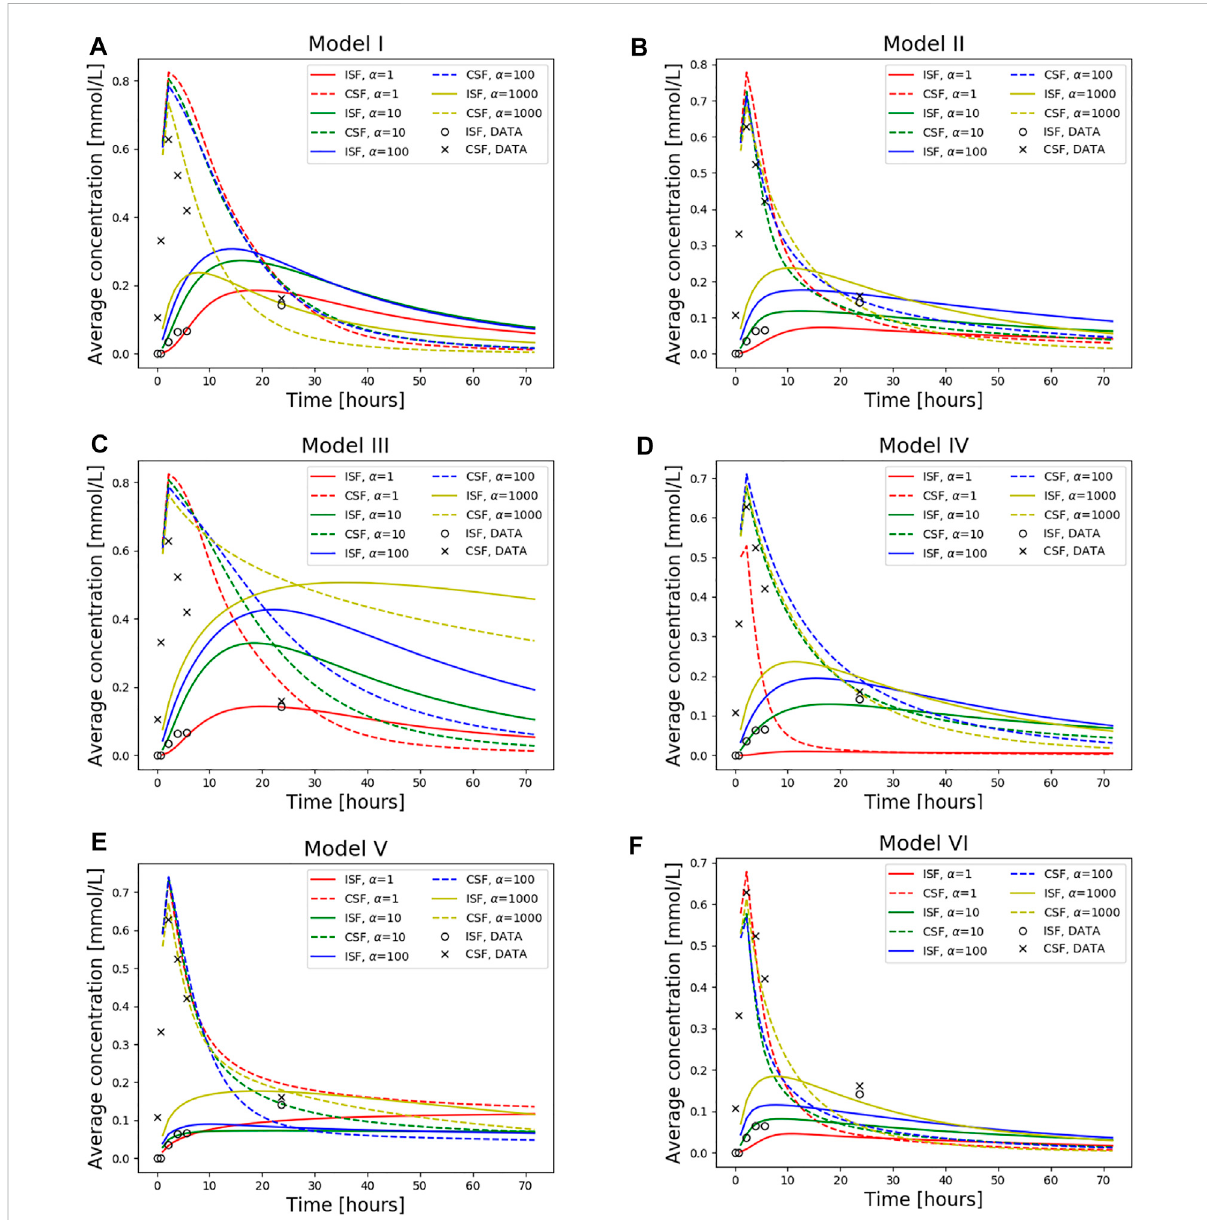
FIGURE 6 Average concentration in the parenchyma (par) and CSF over a period of 72 h. Models I-VI is used with dispersion values α = 1, 10, 100, 1,000. AlsoplottedistheconcentrationdatatakenfromT1-weightedimagesofthisspeci fi cpatientasagroundtruth.Thetracerinjection(presentfrom0to 2.24 h)isseenasasharpincreaseinCSFconcentrationatearlytimepoints.Whentheinjectionisnolongerpresent,thetotalamountoftracerswithin